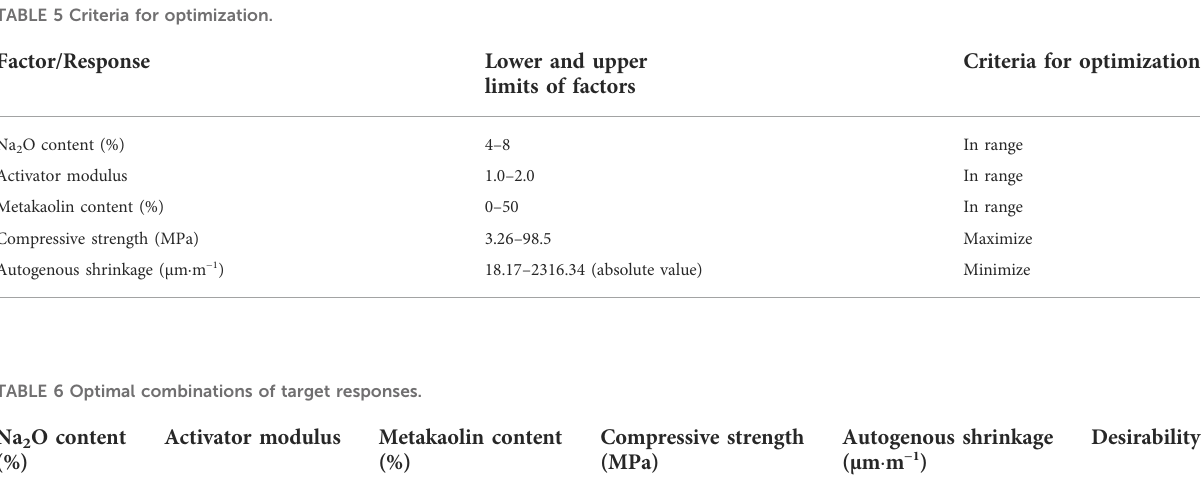
TABLE 5 Criteria for optimization.